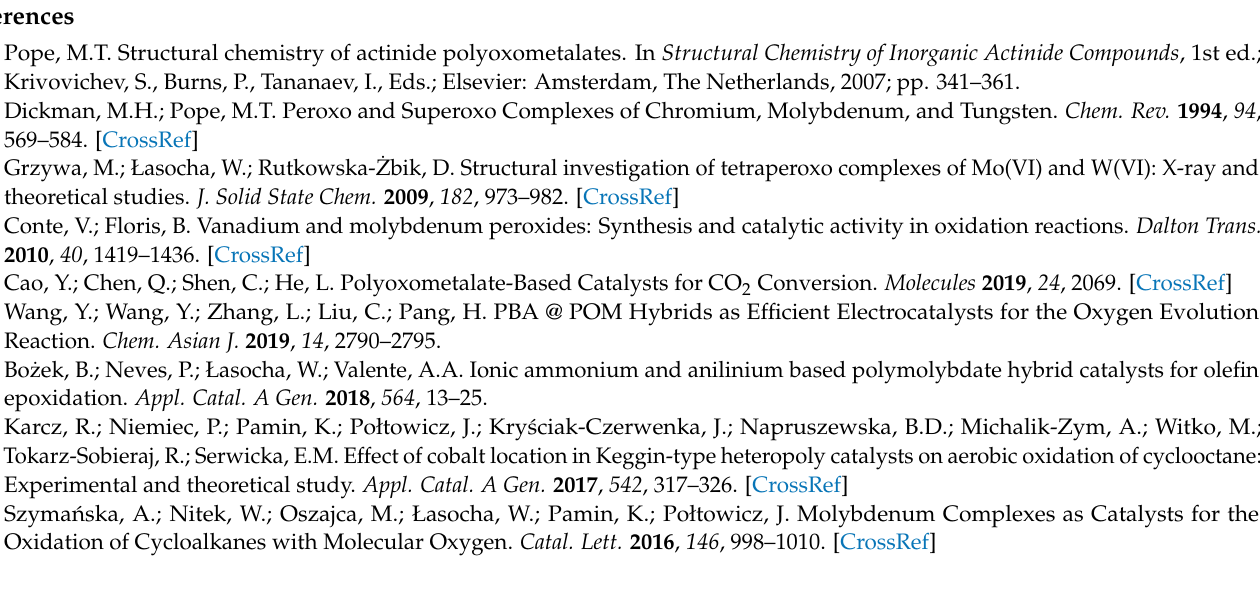
for Na-isoO . Table S1: Interatomic distances for Na-35dcpa and Na-isoO . Table S2: Calculation average size of crystalline d(nm) for Na-35dcpa . Table S3: Calculation average size of crystalline d(nm) for Na-isoO